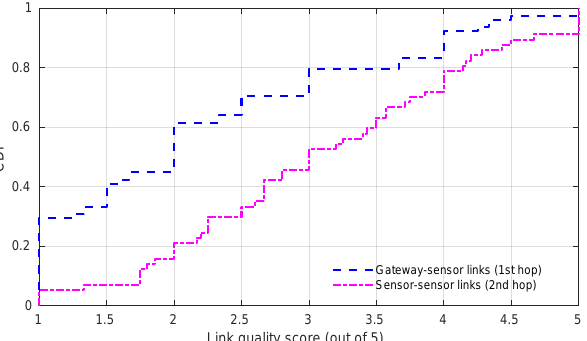
Figure 25. Overall link quality statistics from the North Sea Deployment. When the sensor nodes did manage to find single- or dual-hop links to the gateway, the link quality on the best links was often poor. Notably, the quality of the gateway-sensor links was visibly poorer than than of sensor-sensor (second hop) links; this corroborates the conclusion that the gateway placement (and therefore poor gateway connectivity) was likely the cause of the poor overall network